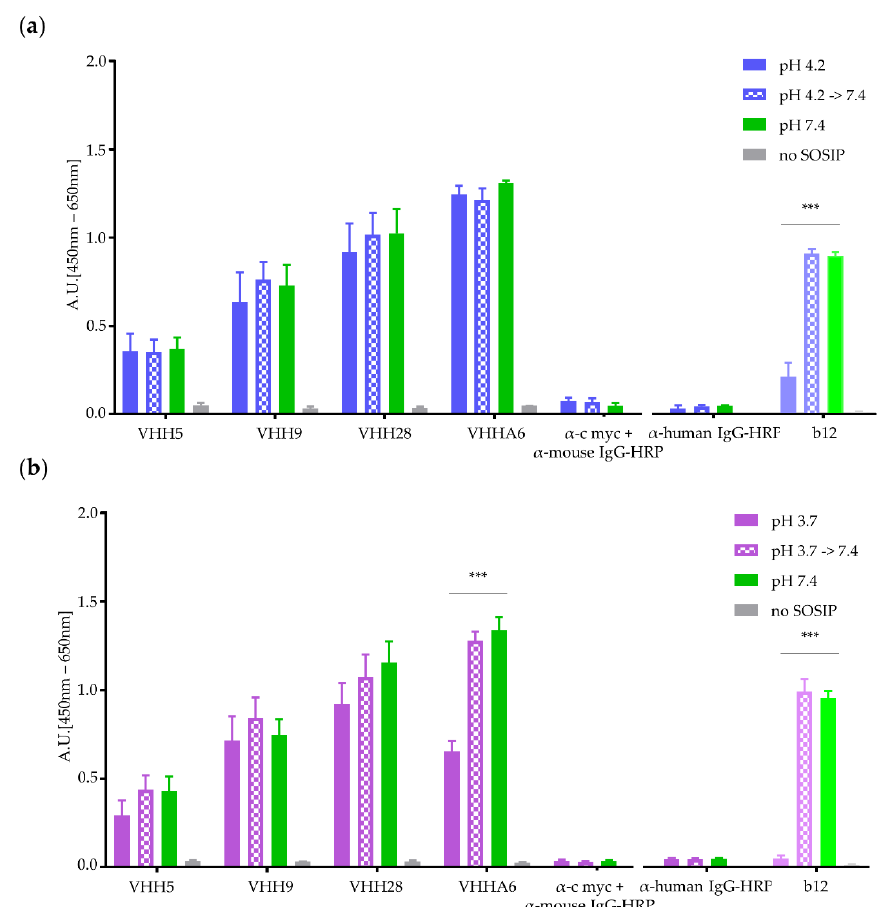
Figure 2. Binding of purified VHHs to optC.664 gp140 SOSIP at acidic pH. Binding experiments were performed using 250 ng of VHHs 5, 9, 28 and A6 [29] and 200 ng immobilized optC.664 gp140 SOSIP at pH 4.2 ( a ) and pH 3.7 ( b ). Binding of VHHs was detected by ELISA via their C-terminal myc-tag. Binding efficiency of VHHs at acidic pH (blue/pink filled bars, respectively) was compared to binding at pH 7.4 (green bars). Full human mAb b12 was included for comparison (detection with α-human IgG-HRP). SOSIP pretreated at acidic pH for 1 h was used as control for antigen integrity (spotted bars). α-c myc and α-human IgG antibodies represent controls without addition of VHHs. Error bars represent SEM of duplicates from three experiments. Statistical differences in absorption between pH 7.4 and acidic pH were determined using t-test. ***: p < 0.001, **: p < 0.01; *: p < 0.05. Binding was performed at pH 4.2 and pH 3.7 and compared to binding of VHHs at neutral pH (7.4) to gain insight into nanobody functionality around the lowest pH (4.0) found in the human vagina. Binding of mAb b12 at the respective pH was analyzed for comparison. Whereas at pH 4.2 reduced. At pH 3.7 (Figure 2b), binding of mAb b12 was already completely abolished. In contrast, all nanobodies were still able to bind to their target, although binding was reduced for VHH 5 and A6. The reduced binding efficiency was not due to acidic effects directly on the Env target protein, as